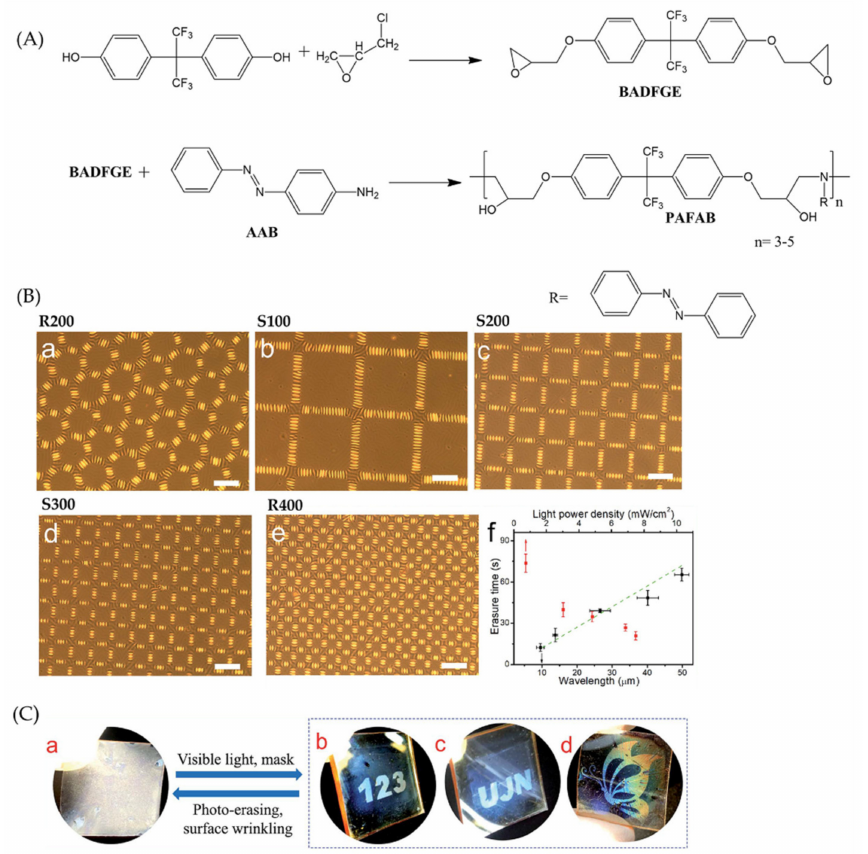
Figure 6. ( A ) Schematic illustration of the process used to synthesize the epoxy-based oligomer (PAFAB), ( B ) optical images of the patterns of wrinkles on the PDMS/PAFAB bilayer system irradiated with visible light through different copper grids (R200 (a), S100 (b), S200 (c), S300 (d), and R400 (e)) and their dependence of the optical erasure time on the light power density and the wrinkle wavelength (f) and ( C ) applications of the PDMS/PAFAB wrinkling system for rewritable information storage as a result of selective exposure to visible light: as-fabricated wrinkle-forming surface (a); various patterns of wrinkles obtained by selective exposure via different photomasks (b–d). Reproduced with permission from reference [46]. Copyright 2020, Royal Society of Chemistry